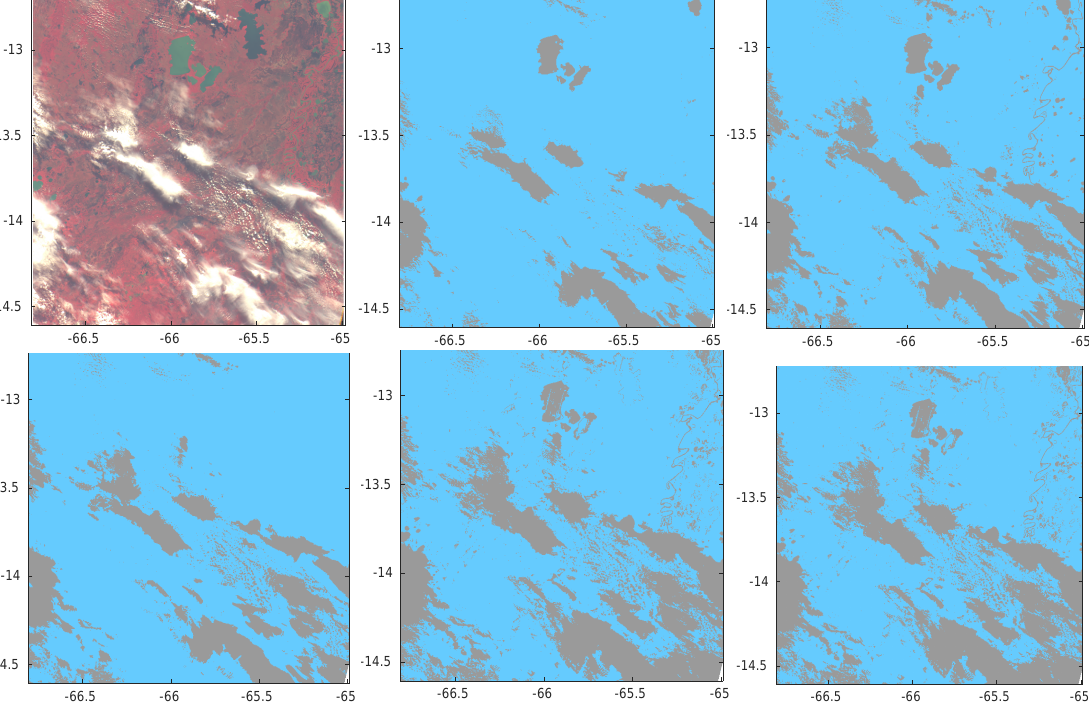
Figure 4. RGB image acquired on 21 June 2014 at 14:42 UTC over Bolivia (top-left panel). Other panels show cloud masks obtained by LDA, PCDA, CDA, ANN and KNN (orderly from left to right and from top to bottom). A single classification was made on the full joint training dataset SEVIRI and